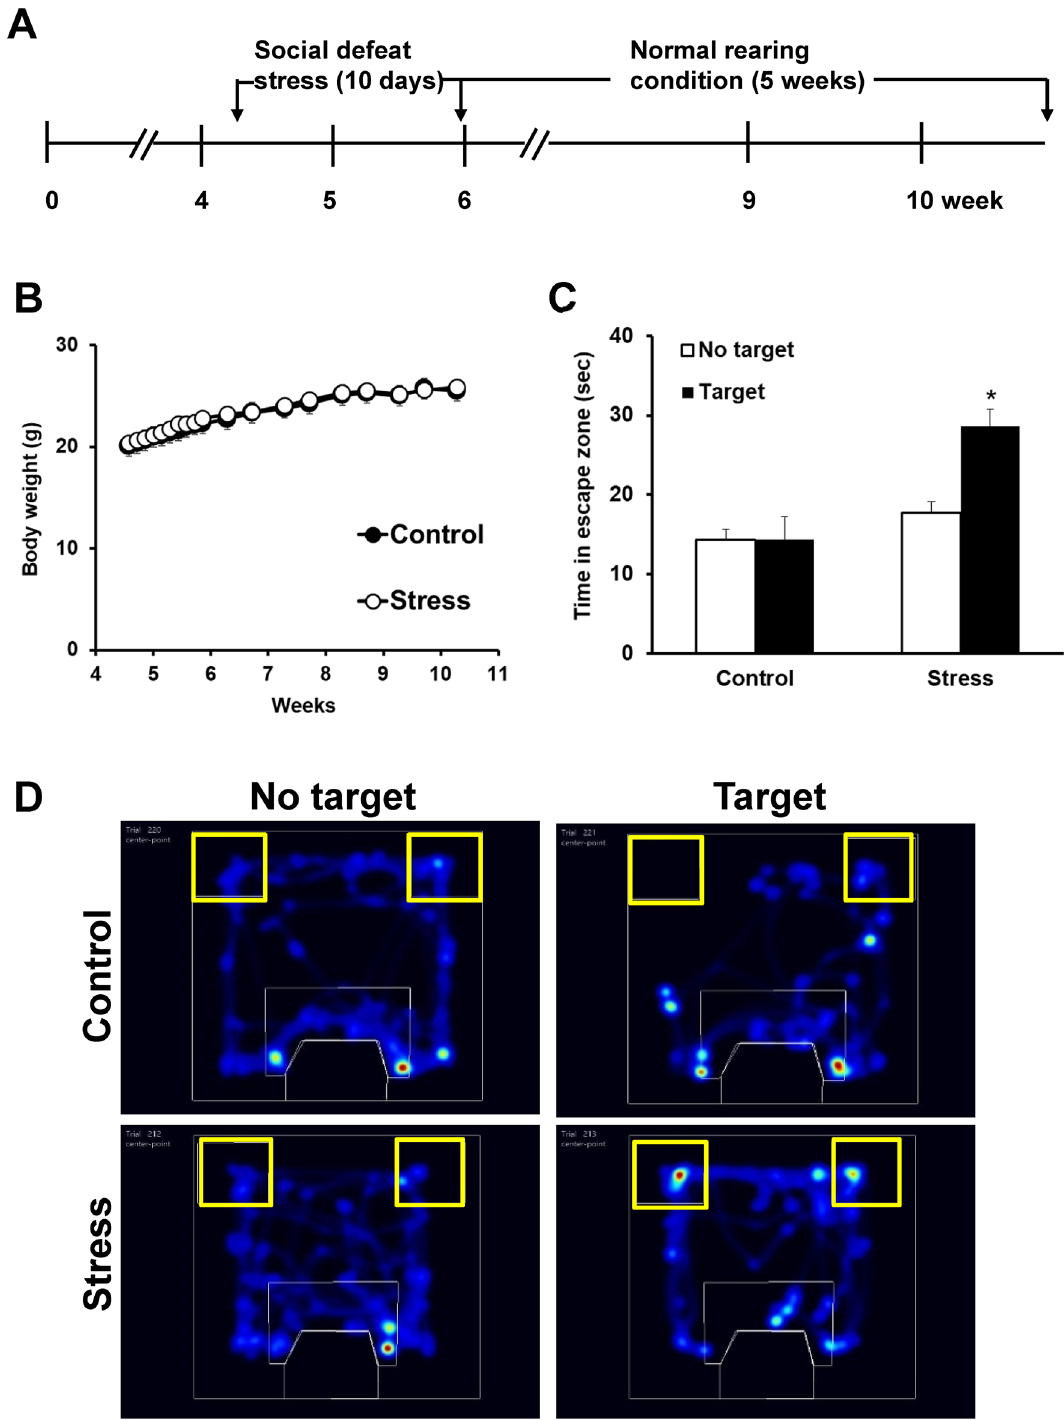
Figure 1. Social avoidance behavior was identified at 5 weeks after the exposure of juvenile social defeat stress (stress). ( A ) Protocol of juvenile SDS. ( B ) Body weight change during the juvenile stress and post-stress periods. ( C ) Duration of time spent in the escape zone (yellow square) with (target) or without (no target) aggressor mouse. ( D ) Representative results of heat maps in social interaction test with or without aggressor mouse. Data are presented as the mean ± SEM (n = 8 mice per group). * p < 0.05 for comparison with the corresponding no